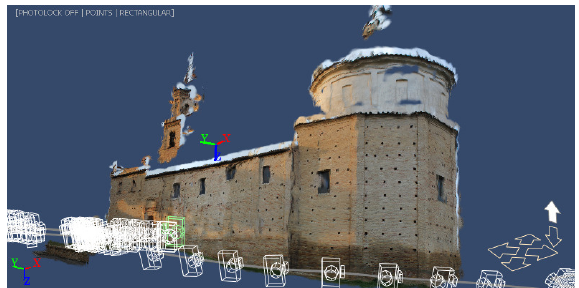
Figure 13. Santa Maria in Piano, Loreto Aprutino (Pescara), Automatic Reconstruction, Rear View